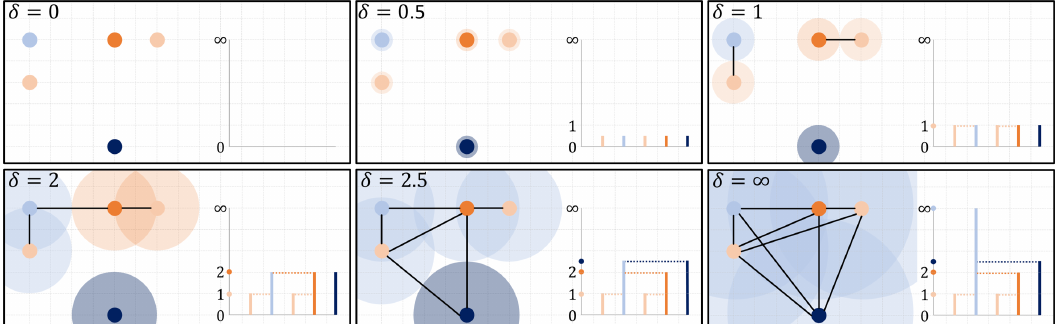
Figure 1. A Rips filtration over a point cloud captures the merging dynamics of clusters evolving from points across multiple scales. The dimension zero persistence diagram produced by this filtration is a set of points positioned along an extended vertical line at the merging heights in the corresponding dendrogram, except for the last point positioned at ∞ representing the eventual single component. The neighborhoods around points are colored by the persistent cluster determined by the elder